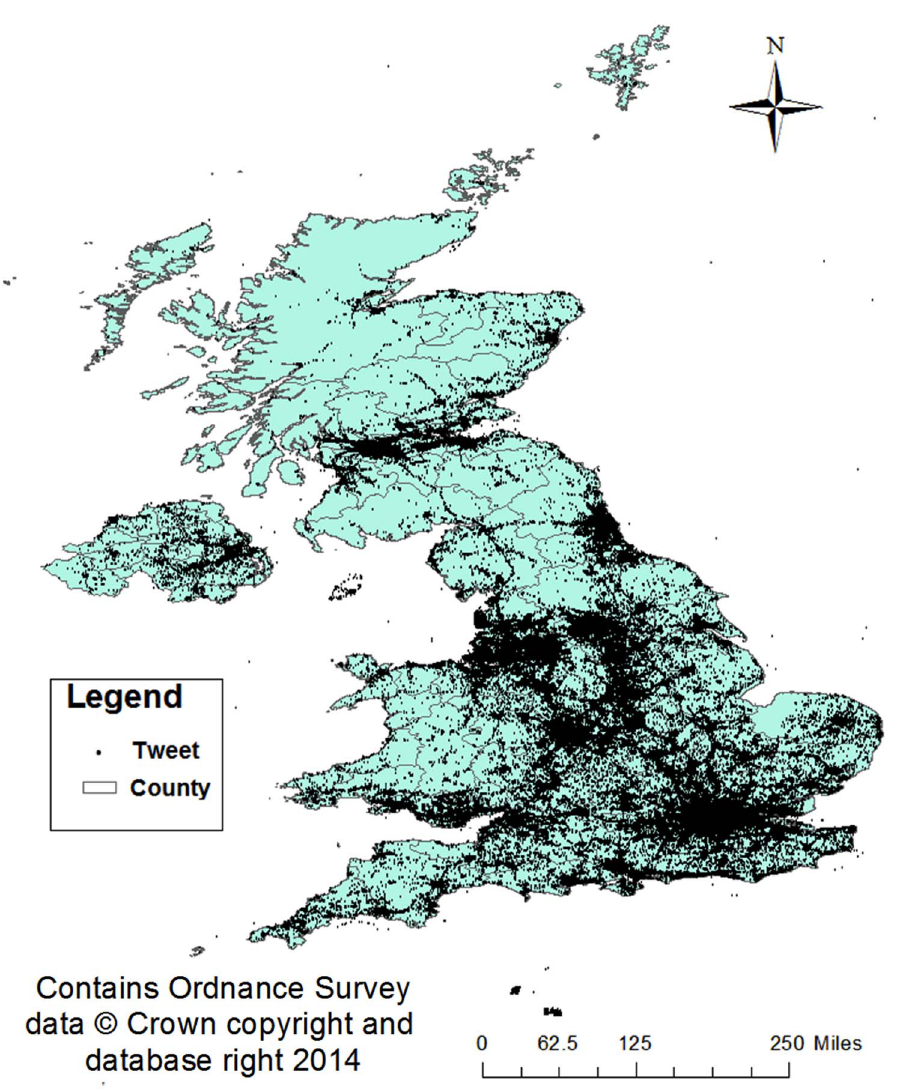
Figure 1. The locations of tweets collected between 7th January and 18th January 2013.